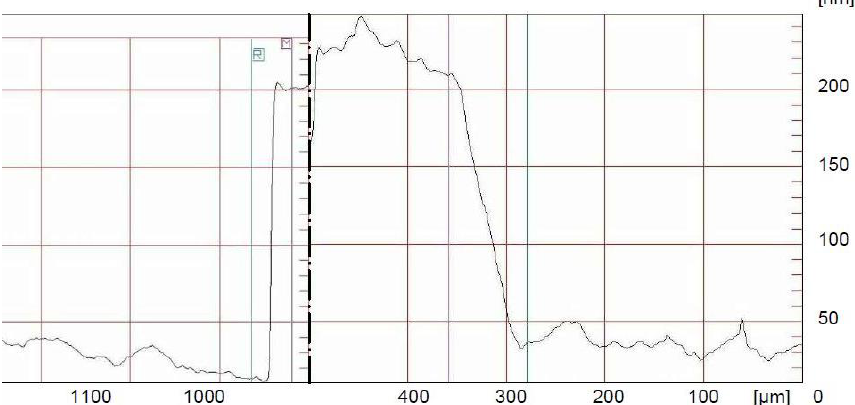
Figure 6. Profile thickness of layers on the edge and in the middle of the cross-section of the test structure.